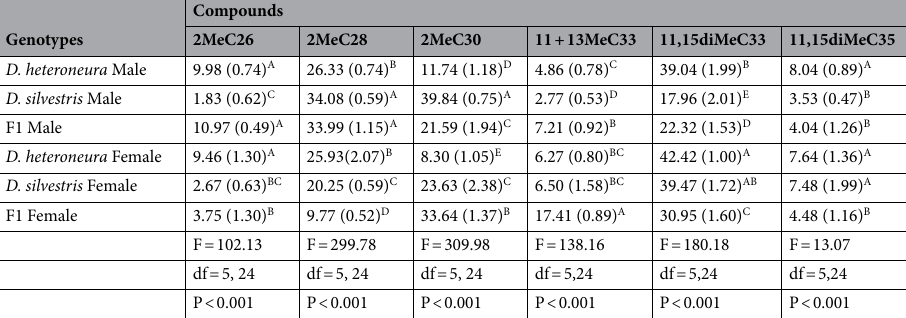
11,15diMeC33 outside the range of the parental species. The two backcross females differed significantly from D. silvestris , but not D. heteroneura for 11,15diMeC31, and both backcross females differed from D. heteroneura but not D. silvestris for 11,15diMeC35. The abundance of 2MeC32 and 11,15MeC33 in the backcross females did not differ significantly from that for D. silvestris, with BC-H females showing significant differences from D. heteroneura for 11,15MeC33 (Table 3).